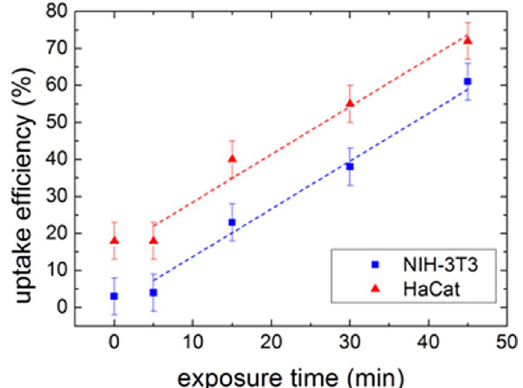
Figure 1. Uptake efficiency versus exposure time, evaluated by flow cytometry analysis on NIH-3T3 and HaCaT cell lines treated with 1 MHz US at I spta = 7 mW/cm 2 . Dashed line: linear regression fits (correlation coefficient R = 0.993, p = 0.00075 blue line; R = 0.986, p = 0.0144 red